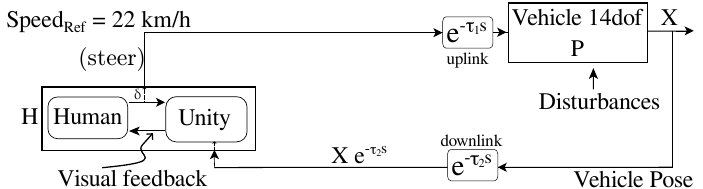
Figure 3. Schematic of typical vehicle teleoperation data